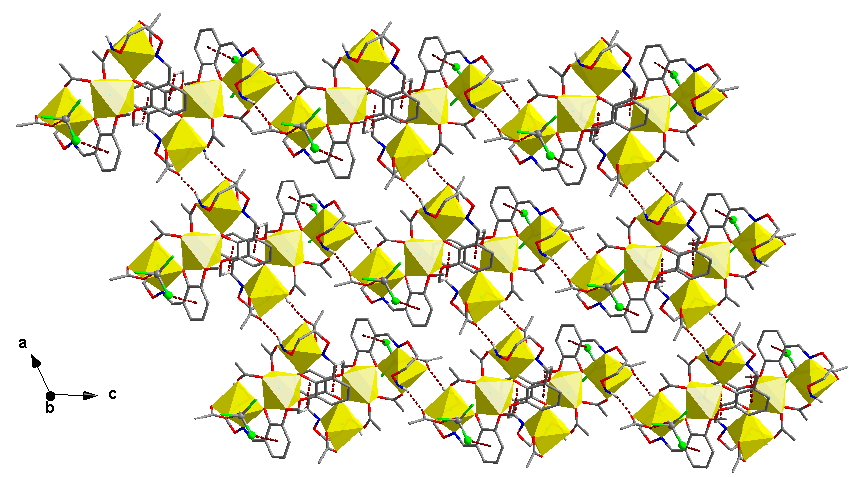
Figure 6. View of the 2D supramolecular structure of complex 2 showing the N-H ··· O, C-H ··· O hydrogen bonding, and C-Cl ··· π , C-H ··· π stacking